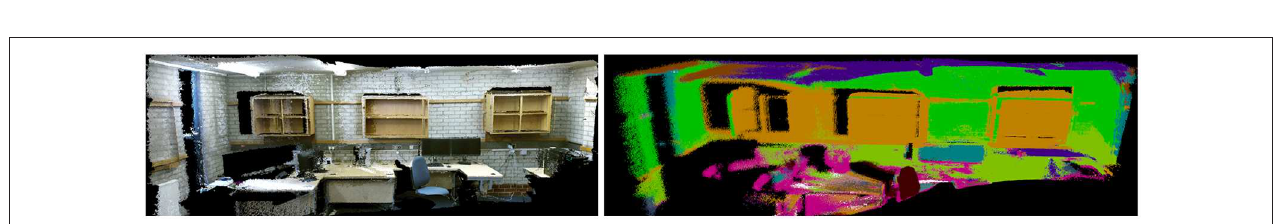
FIGURE 6 | The qualitative results of each step generated by the material segmentation and reconstruction system. The first column are RGB images from Kinect2, the second column are material segmentation images, the third column are 3D point clouds, and the fourth column are 3D semantic point clouds.